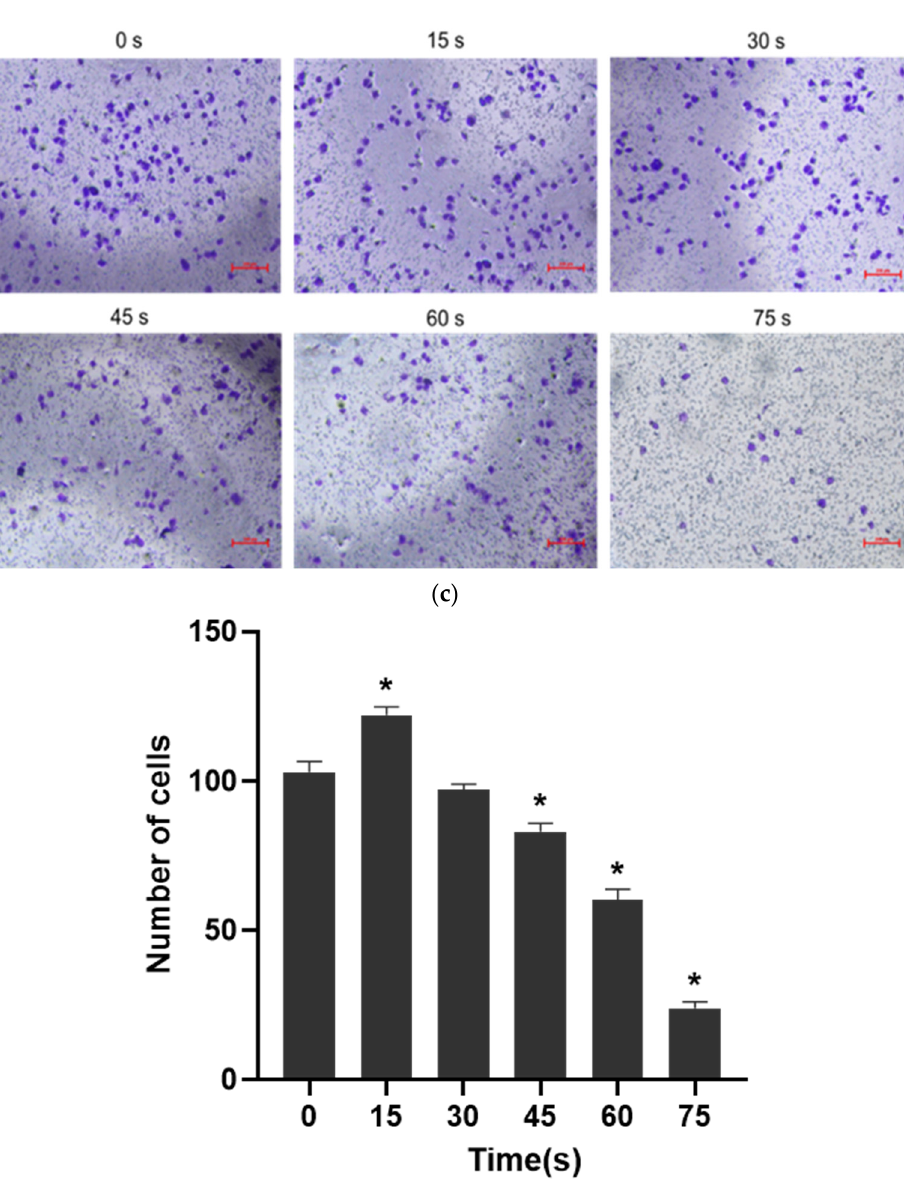
Figure 4. ( a ) Typical pictures of the effects of scratch healing test (40×) at different time (0 h, 12 h and 24 h). ( b ) Cell healing rate * p < 0.05 compared with control group (0 h). ( c ) Typical photos of the cells on the lower surface of the Transwell insert membrane (40×). ( d ) Results of single-layer penetration experiment. The number of cells was increased in the 15 s-PAM group and decreased in the 45 s, 60 s and 75 s-PAM group. * compared with control group (0 s) p < 0.05.